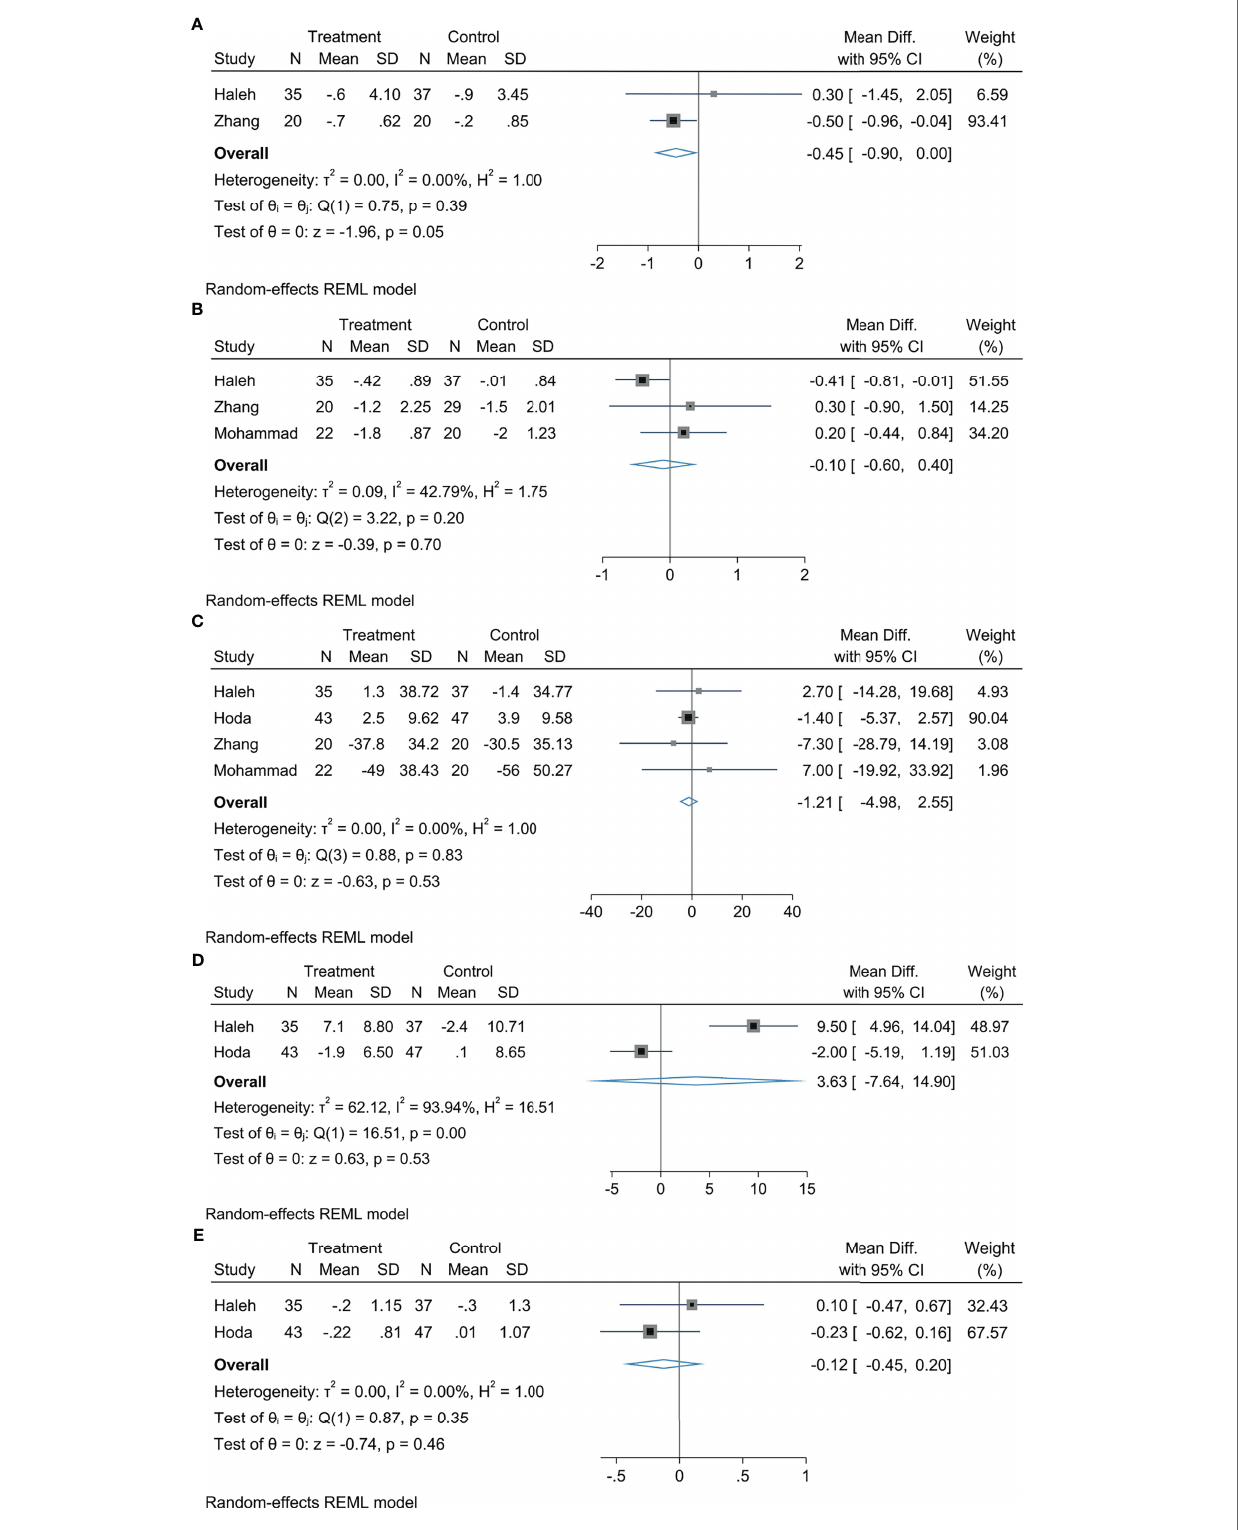
FIGURE 4 | The effect of empagli fl ozin on HOMA-IR (A) ; the effect of empagli fl ozin on HbA1c (B) ; the effect of empagli fl ozin on FBS (C) ; the effect of empagli fl ozin on insulin (D) ; the effect of empagli fl ozin on HOMA2-IR (E)